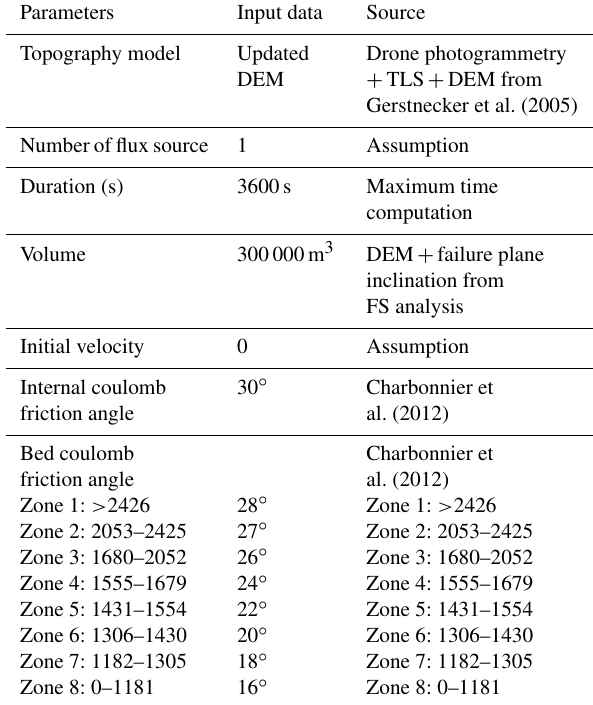
Table 2. Detail input parameters in Titan2D